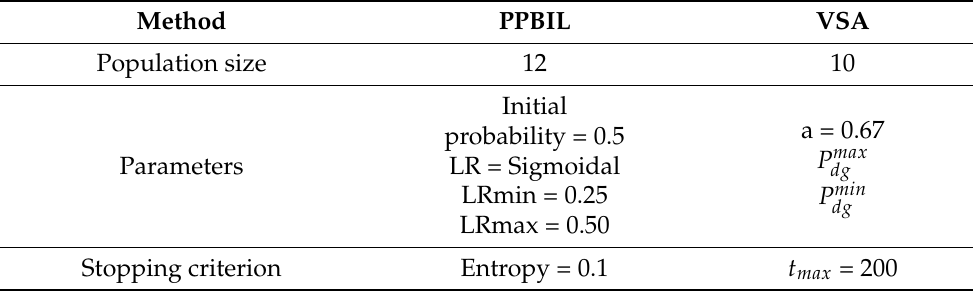
Table 1. Parameters of the PPBIL and VSA